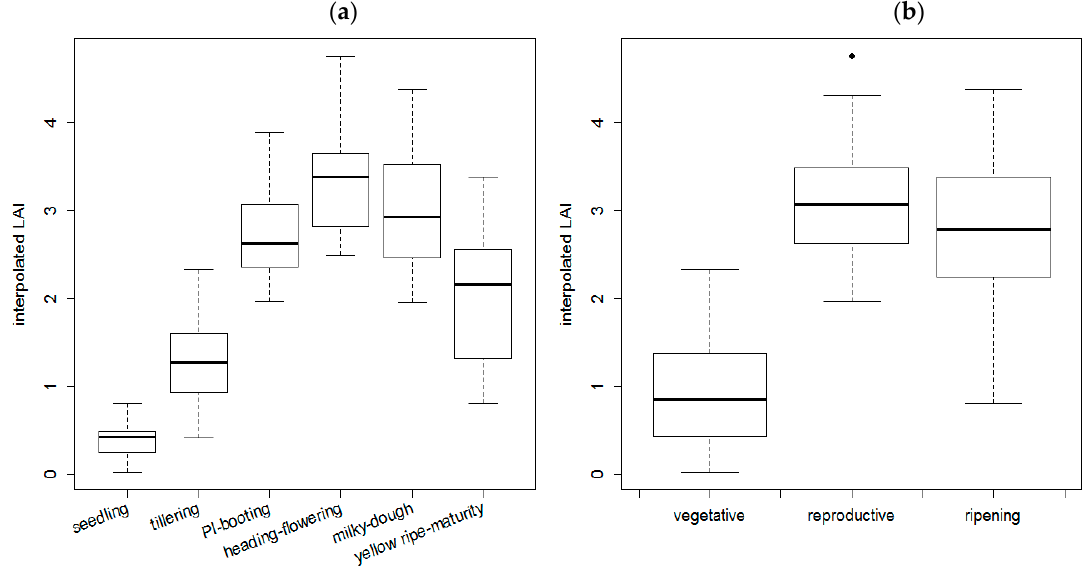
Figure 5. The boxplots of the interpolated LAI per growth stage ( a ) and phase ( b ) for the 30 monitored sites. The following data are shown in the boxplot: median (horizontal black line in the middle of the box), min and max (extent of dashed lines), the 25th and 75th percentile (upper and lower half of the box) and outlier (black dot).